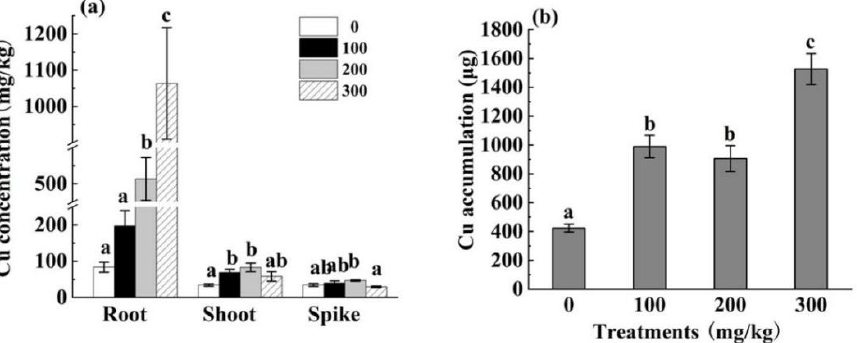
Figure 3. Cu concentrations of all parts of the sea rice ( a ) and its Cu accumulation ( b ). Lowercase letters on the bar chart indicate significant differences among different treatments ( p < 0.05). Data were presented as mean ± standard error (n = 3).